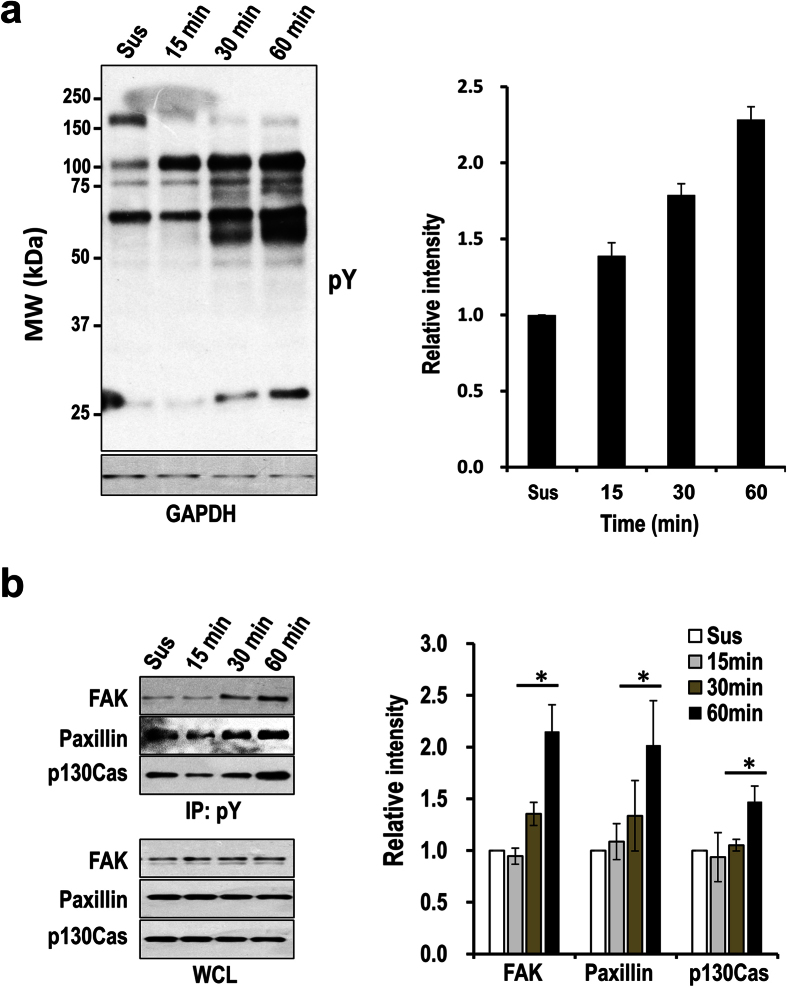
Differential protein tyrosine phosphorylation in cells at different spreading stages.(a) Western-blotting detection of the total pY levels from the cells seeded on 5 μg/ml fibronectin coated dishes for the indicated times. Cells in suspension (Sus) were used as the control, and GAPDH was probed as the loading control (Left panel). Shown is the representative result from three independent experiments. The Western-blotting results were quantified with densitometry and shown in the bar graph (Right panel). The combined pixel intensity from all detectable bands in each lane was used for the analysis. The relative intensities at the different time points were shown as the fold changes over that of the cells in suspension. Error bars indicate standard deviations. (b) Detection of total pY level of FAK, Paxillin, and p130Cas in the cells treated as in (a) using immunoprecipitation coupled with Western-blotting. The total pY proteins were immunoprecipitated from the WCL, and the pY form of FAK, Paxillin, and p130Cas were detected by Western-blotting using antibodies specific for these proteins. Total levels of the indicated proteins in WCL were also probed as the loading control (Left panel). The pY forms of the indicated proteins detected by immunoprecipitation and Western-blotting were quantified with densitometry from three independent experiments and shown in the bar graph (Right panel). Error bars indicate standard deviations. *p < 0.05. Note that phosphorylation of Paxillin is slightly higher in control cells (Sus) than the cells at the time point 15 min, this is probably caused by cell manipulation such as buffer changes during the experiment.